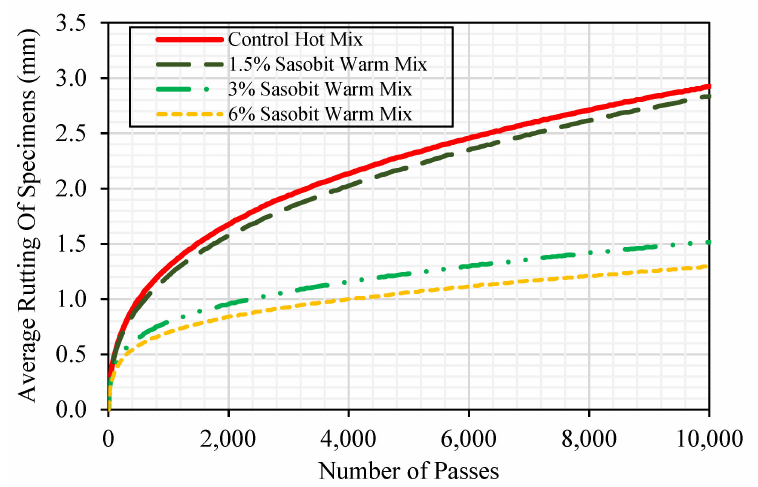
Figure 15. Comparison of wheel tracking results for HMA and